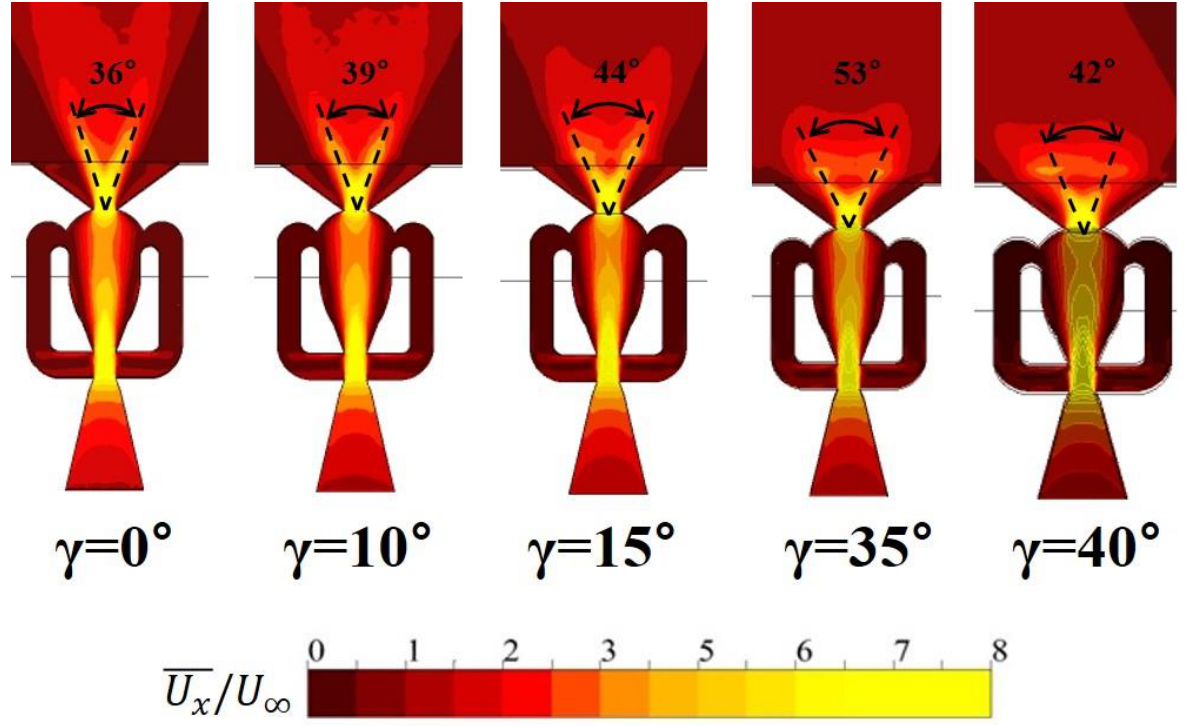
Figure 11. Time-averaged velocity contours and exit jetting angle (Case1).